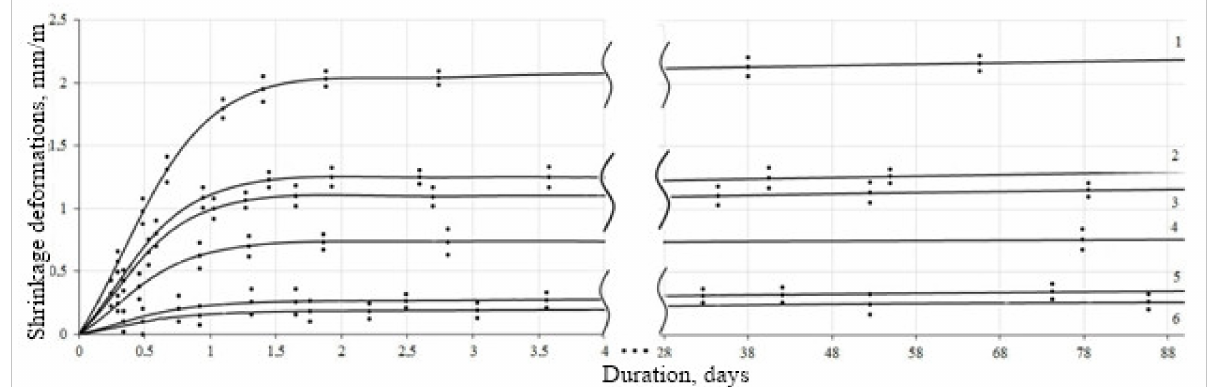
Figure 8. Shrinkage kinetics of finishing mixes: 1—Ref-2; 2—Ref-1; 3—03B; 4—03A; 5—03D+S-3+Neolith 7200; 6—03C+S- 3+Pulver DM 1142P.